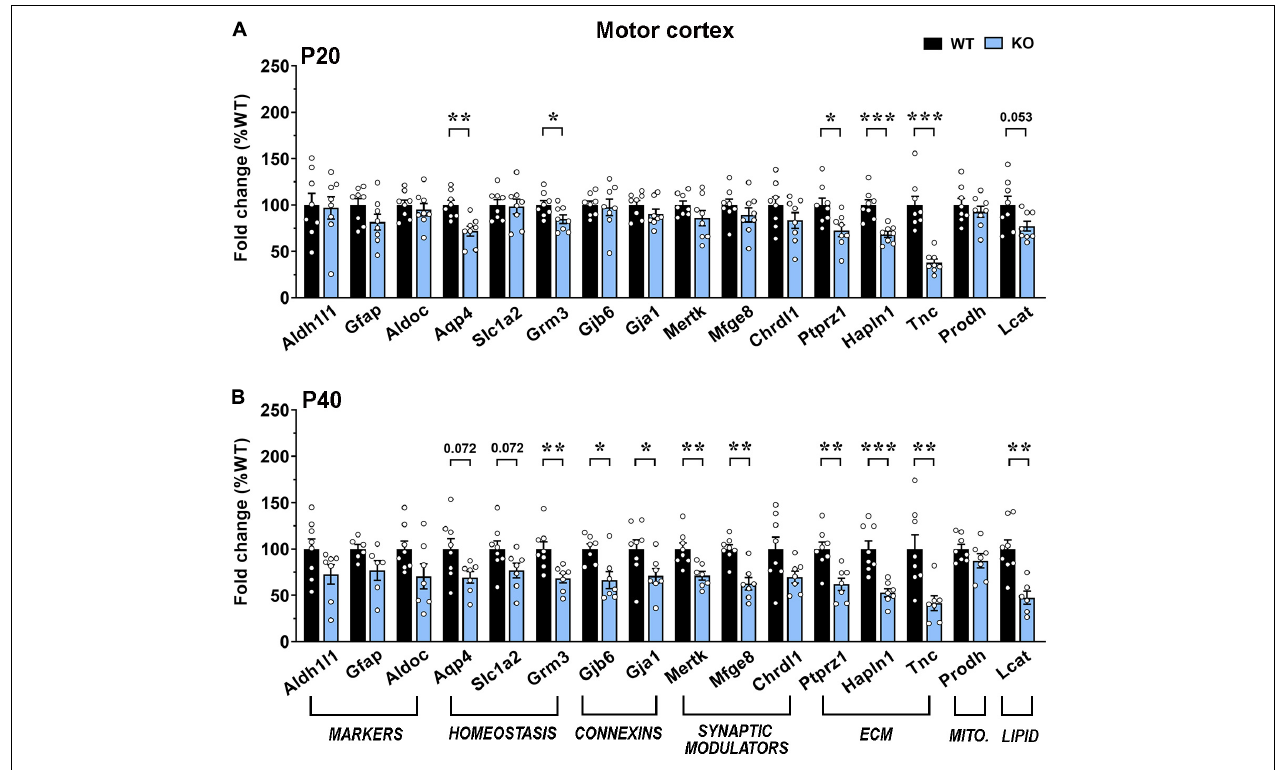
FIGURE 6 | Transcriptional expression of astrocytic genes in the motor cortex of early-symptomatic and moderate symptomatic Mecp2 KO animals. (A,B) The graphs depict the mRNA expression of selected astrocytic genes in motor cortex of early-symptomatic [at P20 (A) ] and moderate symptomatic [at P40 (B) ] KO mice, compared to the corresponding WT littermates. Data are represented as mean ± SEM. * p < 0.05; ** p < 0.01; *** p < 0.001 by Student’s t -test or Mann–Whitney test in accordance with data distribution. Eight animals per genotype were used at each time point ( N =